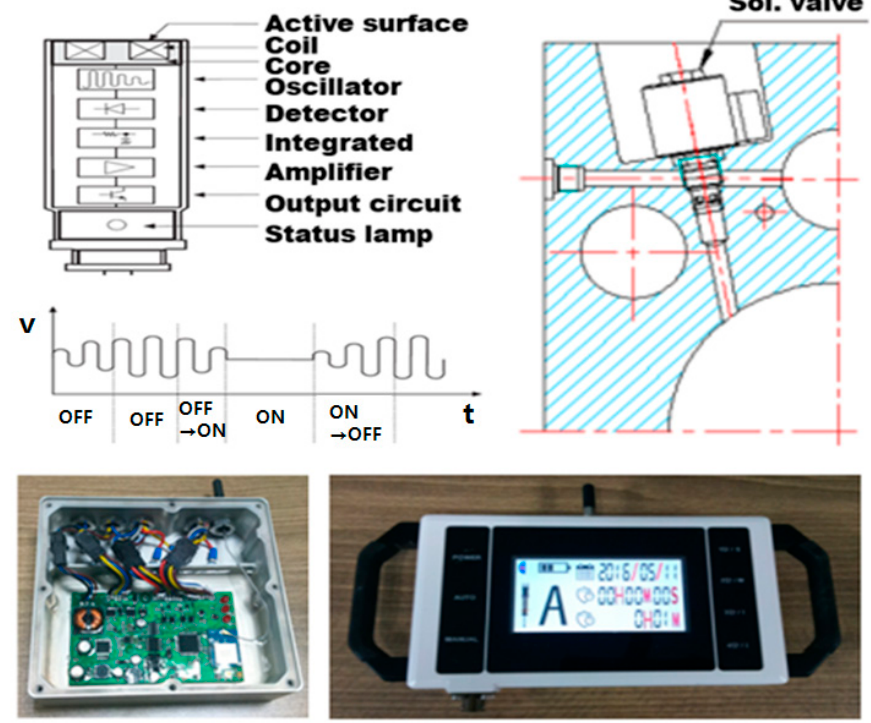
Figure 5. Proximity sensor, solenoid valve, controller, and display panel with control keys.